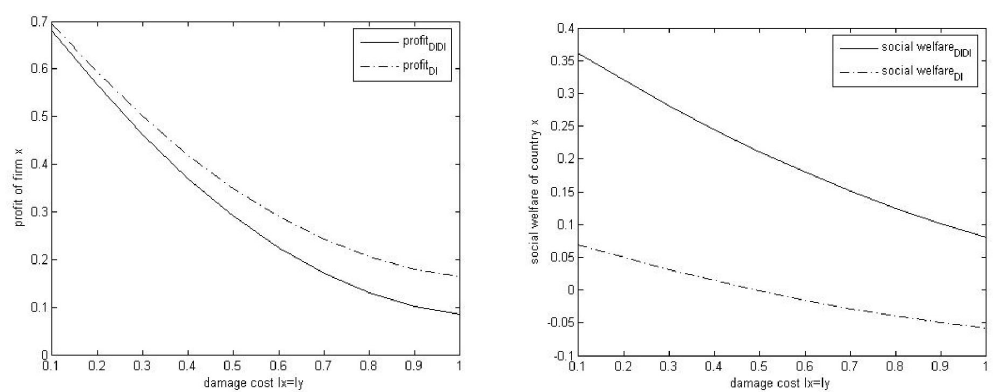
Figure 1. The comparison of π x and R x between DIDI and DI